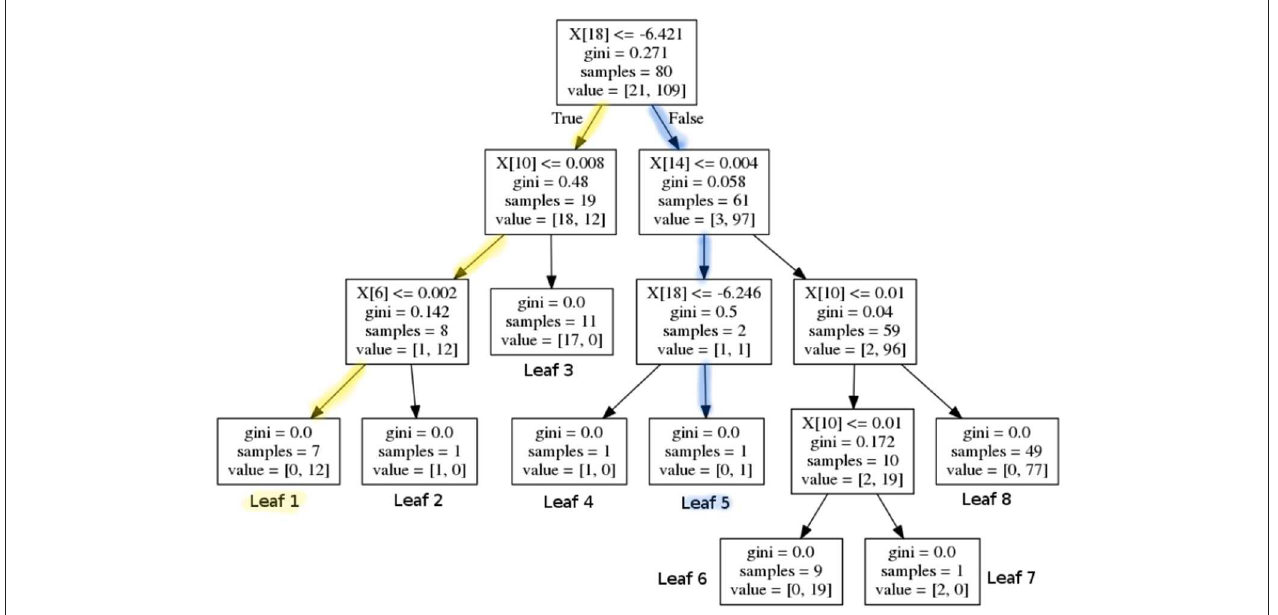
FIGURE 2 | A sample decision tree that would lead to eight rules; the yellow (outer left) and blue path (leading to leaf 5) show two exemplary rules that would be extracted from this decision